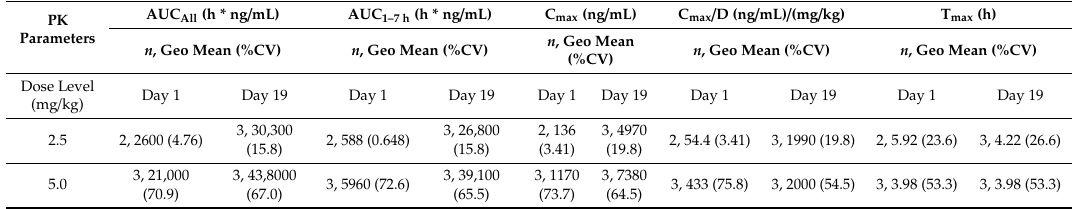
Table 1. Calculated noncompartmental pharmacokinetic parameters for Day 1 (pre-dose, 1, 3, 5, 7, and 24 h) and Day 19 (pre-dose, 1, 3, 5, and 7